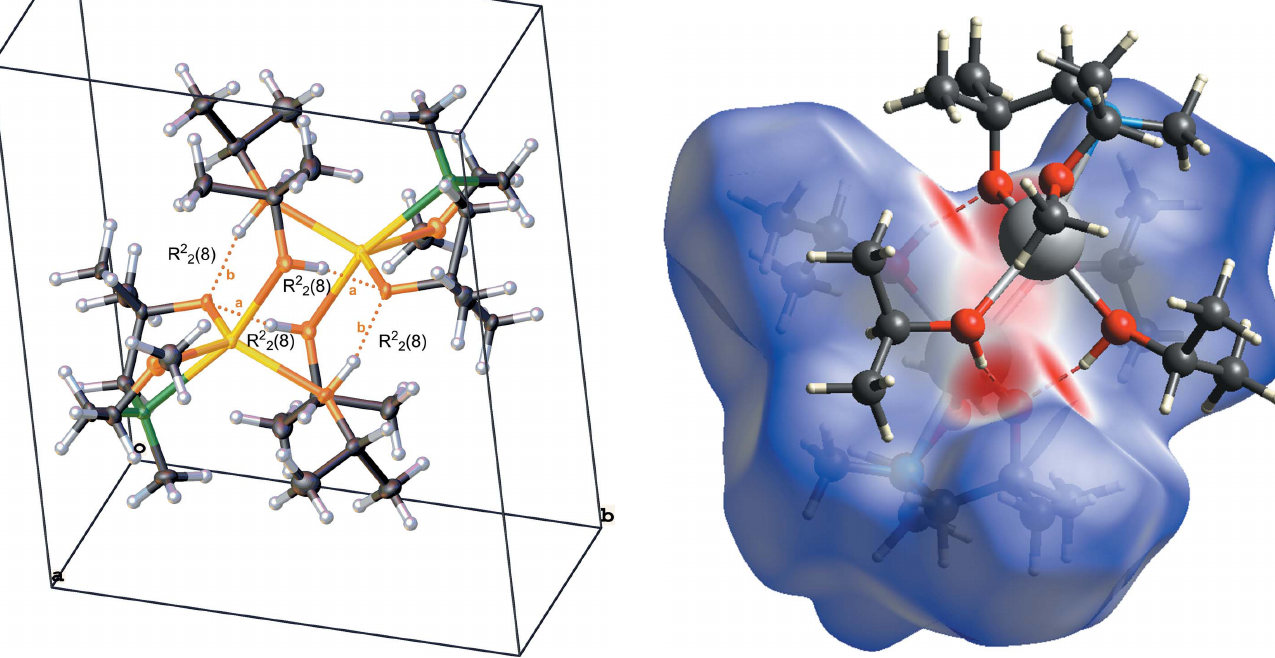
Figure 4 Hirshfeld surface analysis ( CrystalExplorer17; Turner et al. , 2017) of compound 2 illustrating the hydrogen bonding. Symmetry operation a = 1 (cid:3) x , 1 (cid:3) y , 1 (cid:3) z .